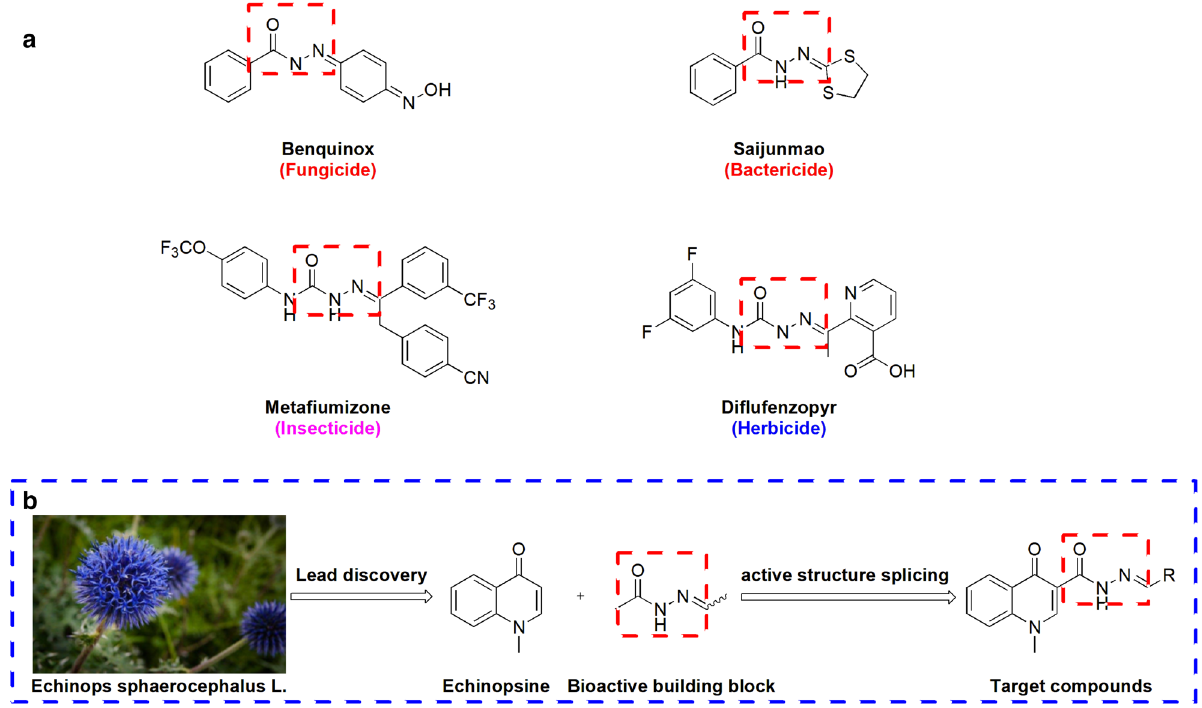
Figure 2. ( a ) Bioactive drugs containing acylhydrazone moieties; ( b ) design strategy for the target